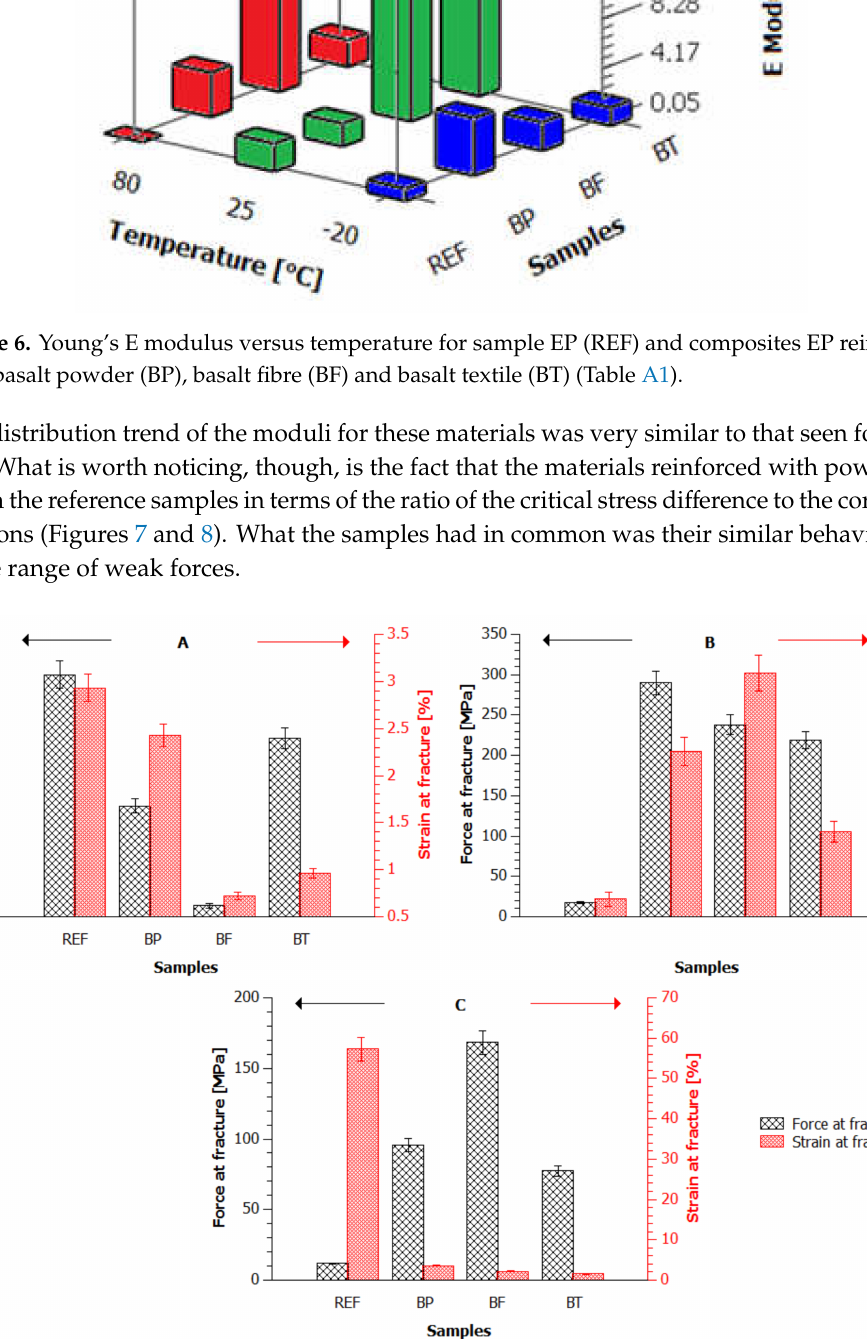
Figure 7. Force at fracture (axis Y1—black) and strain at fracture (axis Y2—red) in relation to sample EP (REF) and composites EP reinforced with basalt powder (BP), basalt fibre (BF) and basalt textile (BT) based on the measurements at a temperature of: ( A ) 25 ◦ C, ( B ) − 20 ◦ C, ( C ) 80 ◦